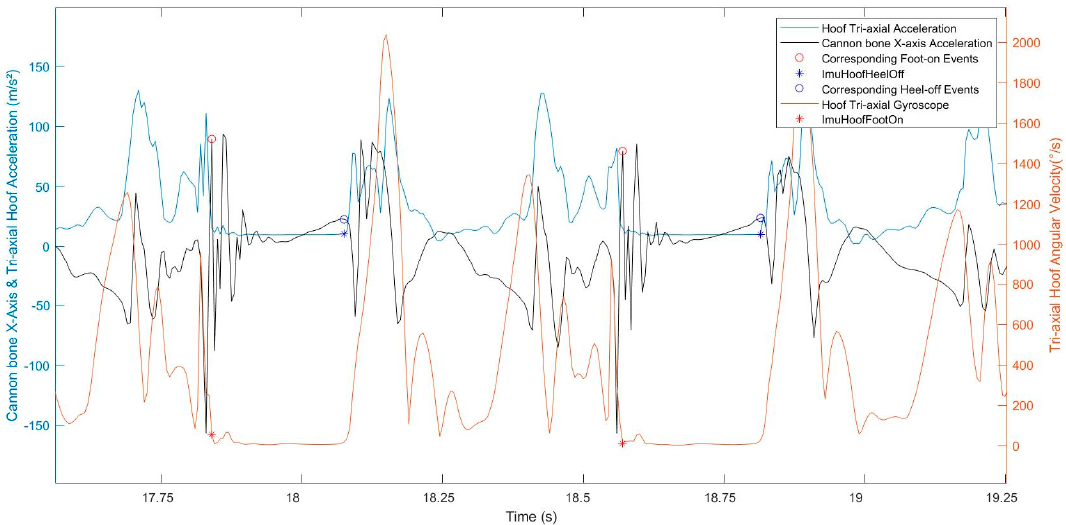
Figure 2. Representation of the normalized signals (normalized by the maximum value) of the hoof tri-axial acceleration (blue curve), the hoof tri-axial gyroscope (red curve), and the cannon bone x -axis acceleration (black curve) of a horse trotting on straight line and hard ground. The red stars correspond to the reference foot-on and the blue stars correspond to the reference heel-off. The cannon bone x -axis acceleration at these same events also appear on the cannon bone curve (blue and red circles on the yellow curve).